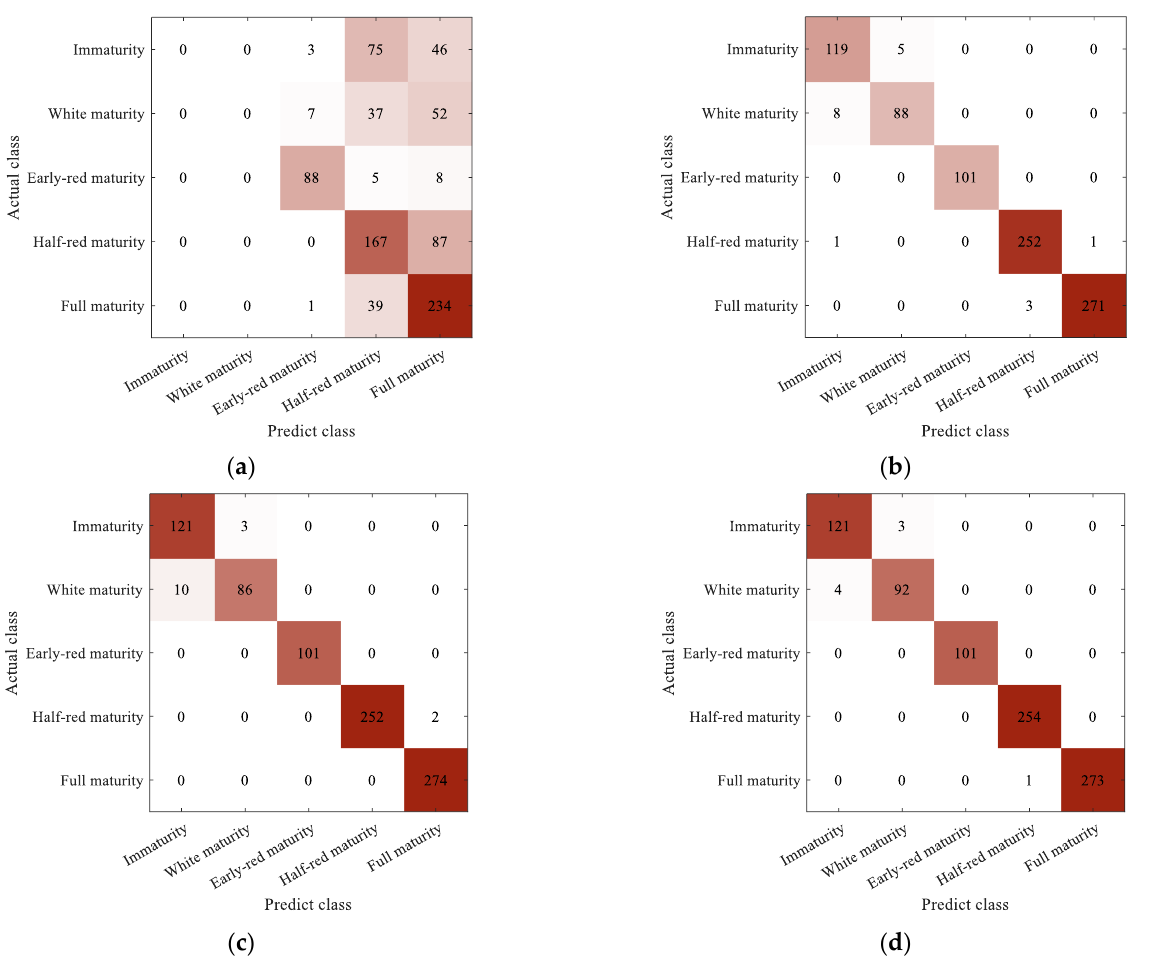
Figure 8. Confusion matrices: ( a ) without transfer learning and without class balance; ( b ) without transfer learning and with class balance; ( c ) with transfer learning and without class balance; ( d ) with transfer learning and with class balance.